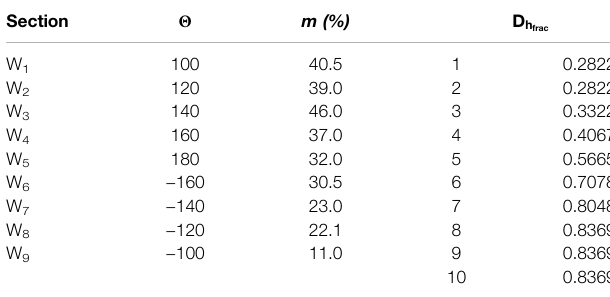
TABLE 6 | Values for θ and m that allow using the same D h sections of the Gemasolar solar fi eld at solar noon during the summer solstice (DNI = 930 W/m 2